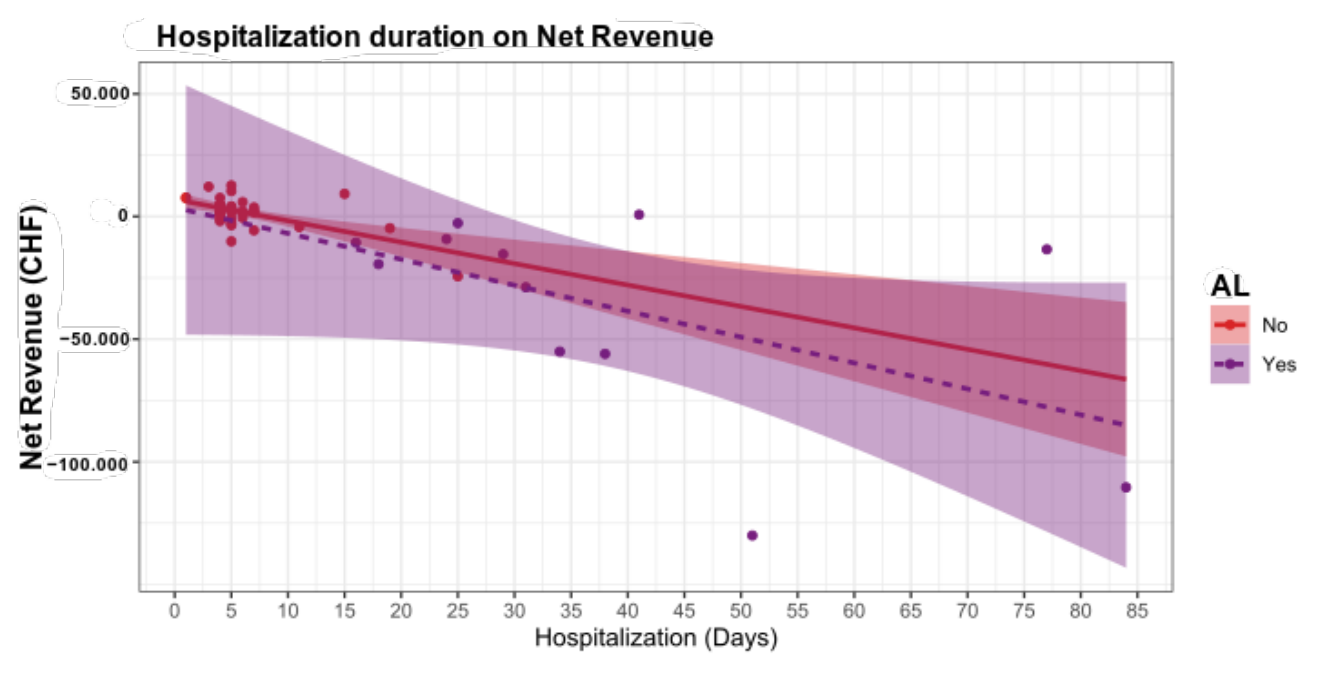
Figure 1. The length of hospital stay is a significant factor influencing the net revenue. In patients without AL, the duration of hospitalization has a minor influence on the net revenue, whereas in patients with AL, losses are already expected from day 4 of hospitalization.